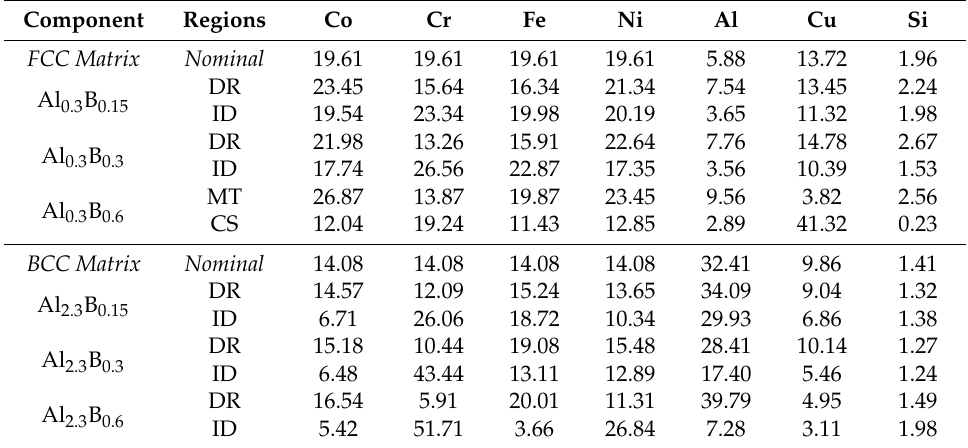
Figure 2. The dendritic (DR) and interdendritic (ID) microstructure in the Al 0.3 B y HEA coatings: ( a , b ) Al 0.3 B 0.15 coating; ( c , d ) Al 0.3 B 0.3 coating; ( e , f ) core–shell (CS) and the magnified matrix (MT) microstructure in the Al 0.3 B 0.6 coating. Table 1. Energy dispersive spectrometry (EDS) results of the elemental distribution in the HEA coatings (boron too small to be detected), at.%.